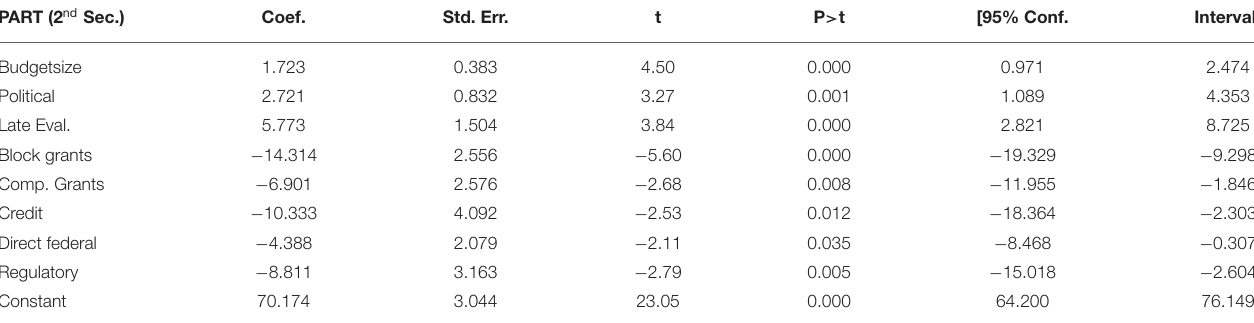
TABLE 8B | Model for strategic planning section of PART. PART (2 nd Sec.)